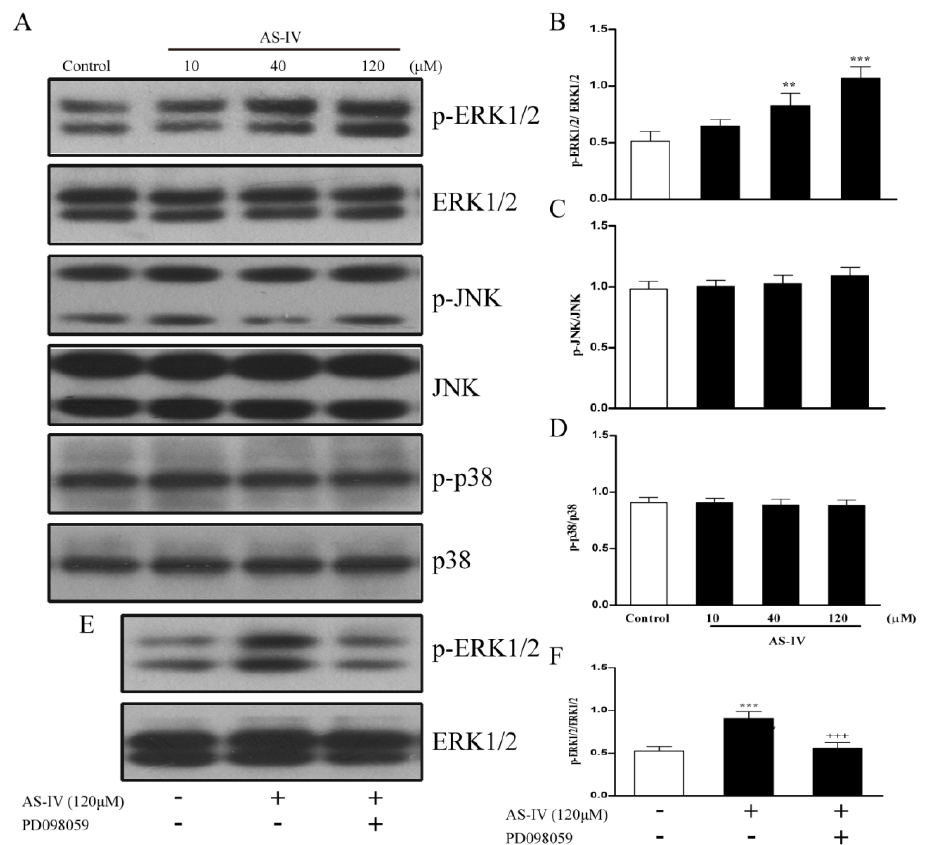
Figure 3. AS-IV promotes the phosphorylation of ERK1/2, but not JNK and p38 in HUVECs. ( A ) Serum-starved HUVECs were treated with AS-IV (10-120 μ M) for 1 h. Cellular lysate was used to measure phosphorylated ERK1/2, p38 and JNK levels by western blot. ( B ) Bar graph represent p-ERK1/2/total ERK1/2 levels. ( C ) Bar graph represent p-p38/total p38 levels. ( D ) Bar graph represent p-JNK/total JNK levels. (E) Serum-starved HUVECs were pretreated with AG490 (100 μ M) and PD098059 (10 μ M) for 1 h before incubation with AS-IV (120 μ M) for 1 h. Cellular lysate was used to measure phosphorylated ERK1/2 levels by western blot. ( E ) Bar graph represent p-ERK1/2/total ERK1/2